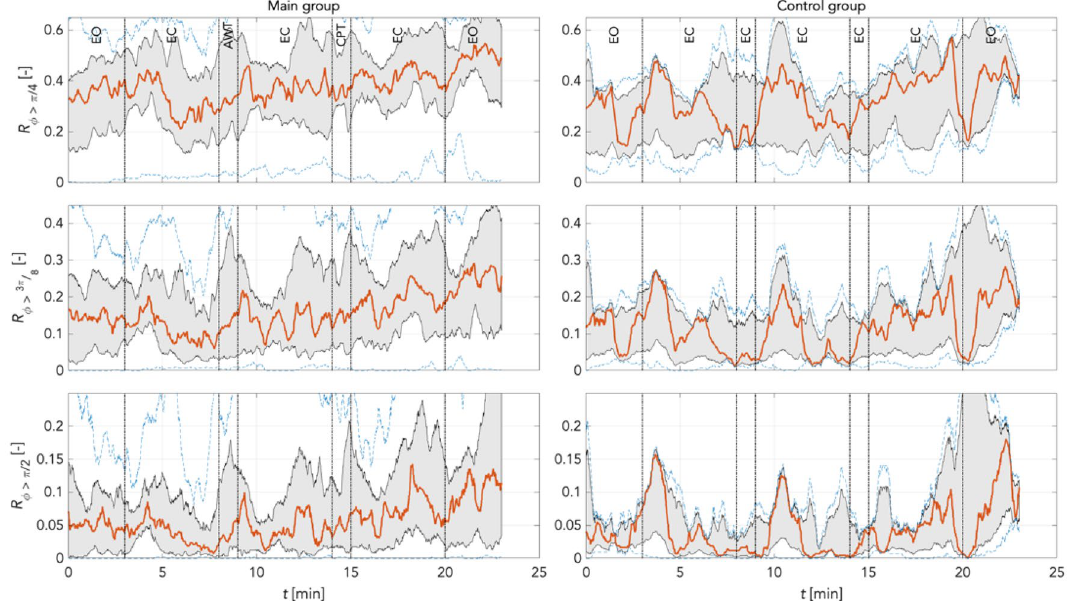
Figure 14. Phase desynchronization for different thresholds for main and control groups in the IM_Ke band (0.12 Hz – 0.18 Hz) excluding 0.1 Hz activity. In the main group, there were hardly any obvious responses to CPT. This group showed also only a slight increase of phase desynchronizations over time. Of note, the control group exhibits for all phase thresholds distinct peaks in phase desynchronizations of approx. 100 s length at minute 4 and 11. Phase desynchronizations increased distinctly at the end of the recordings in 3π/8 and π/2 thresholds. Red: median curve, black vertical lines: stages of the experiment, grey area bounds: 25 th and 75 th percentiles; blue dashed lines: min and max